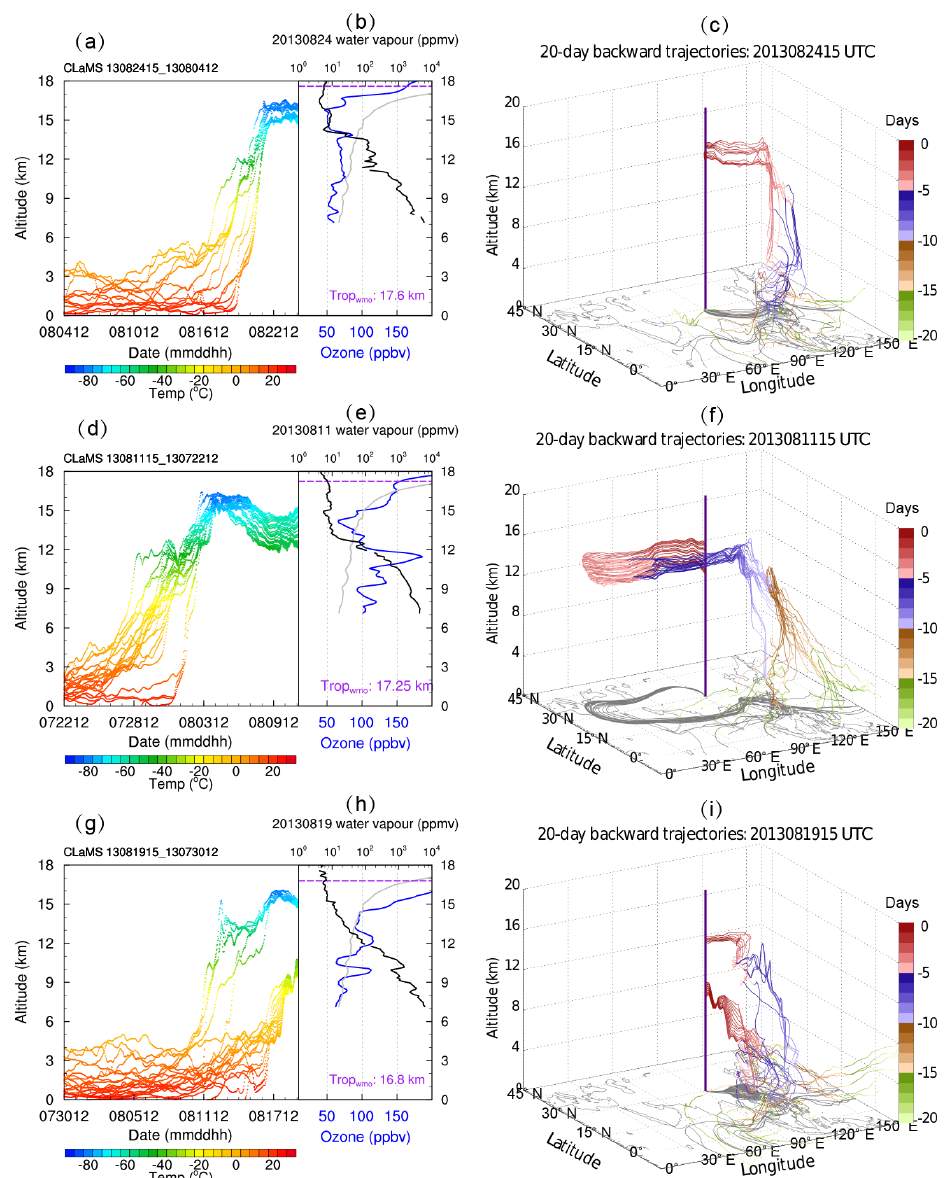
Figure 3. The 20-day backward trajectories started along measured balloon profiles of target parcels on 24 (a, c) , 11 (d, f) , and 19 (g, i) August 2013. Backward trajectories influenced by tropical cyclones Trami, Jebi, and Utor are shown colour-coded by temperature (left). The vertical profiles of ozone (blue line), water vapour (black line), and the mean of ozone profiles in August 2013 (grey line) are also shown (middle). The geographical position (latitude, longitude, and altitude) of the 20-day backward trajectories is given (right) colour- coded by days observed from measurement. The vertical line marks the location of the Lhasa site. The grey lines in the maps show the longitude–latitude projection of the